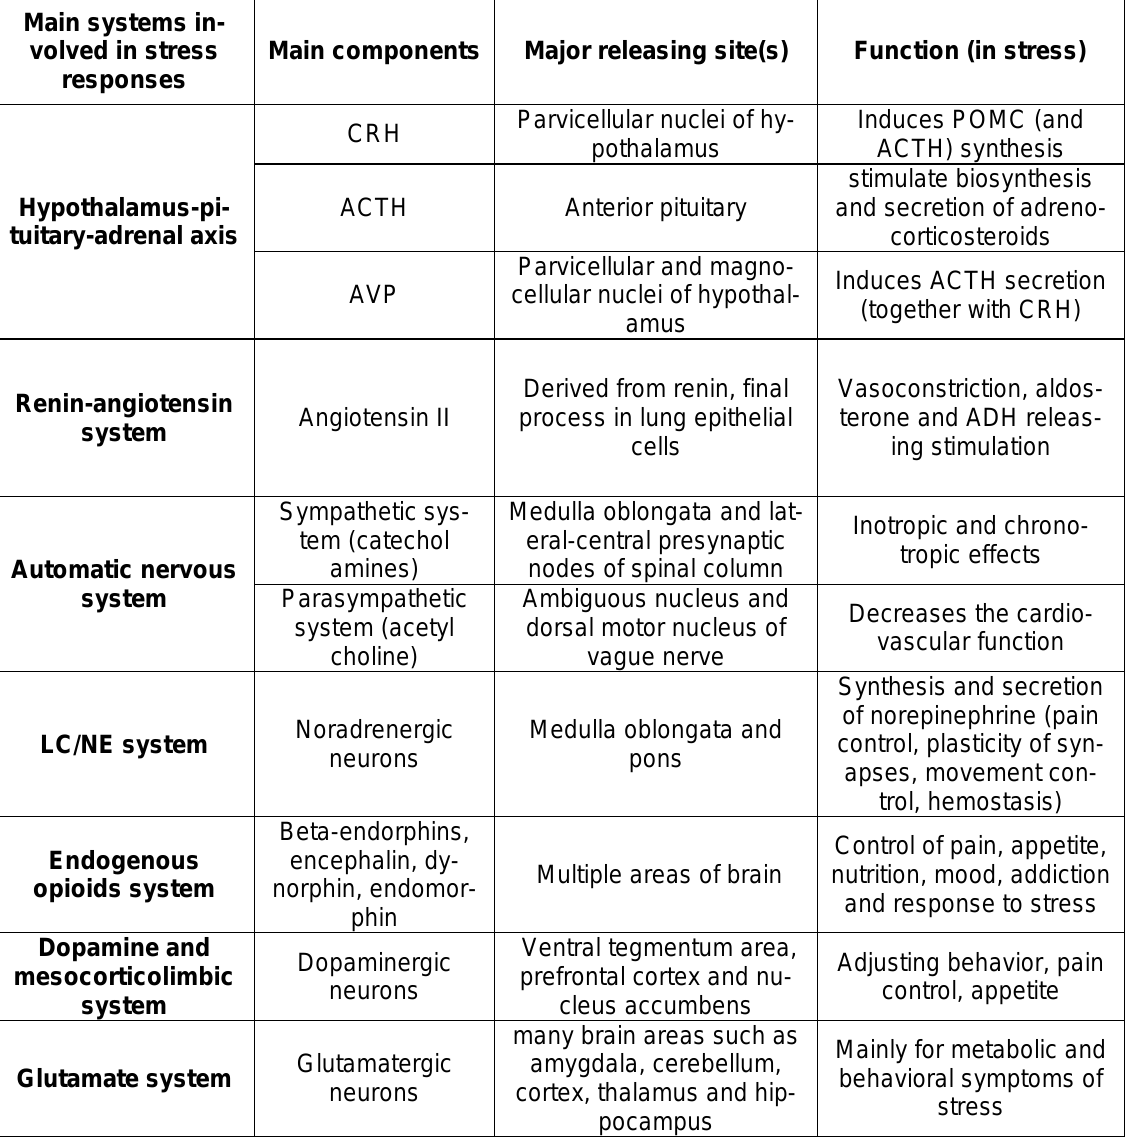
Table 1: Main physiological systems, and their major components, that are involved in the stress re-